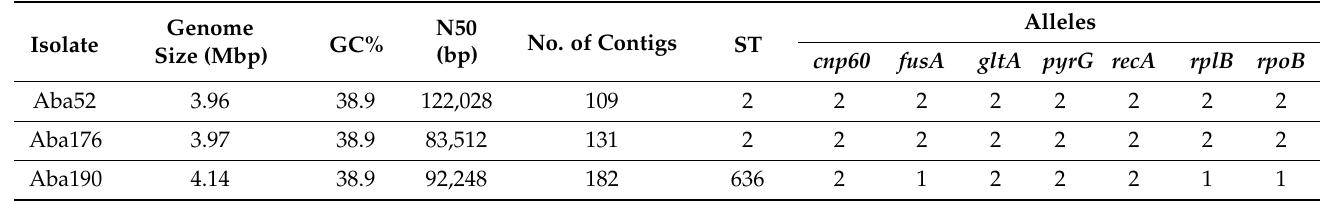
Table 3. Whole genome-based characterization of the studied A. baumannii